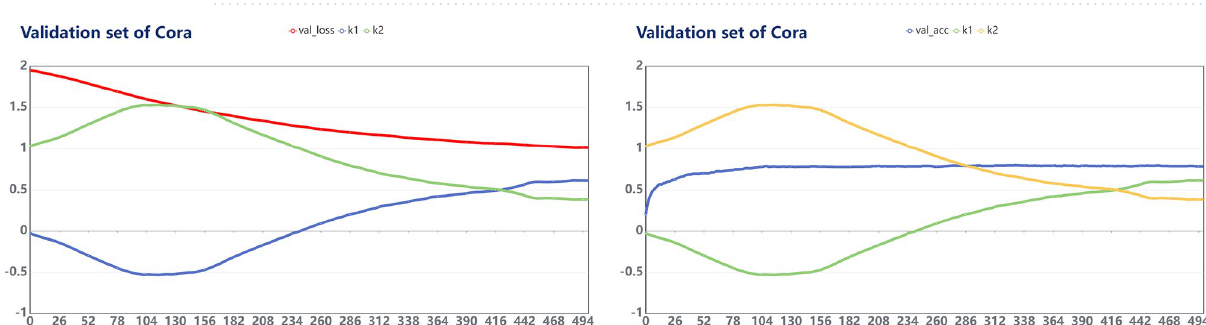
Figure 5. Cora: Fitting relationship between train_acc, train_loss and parameters.